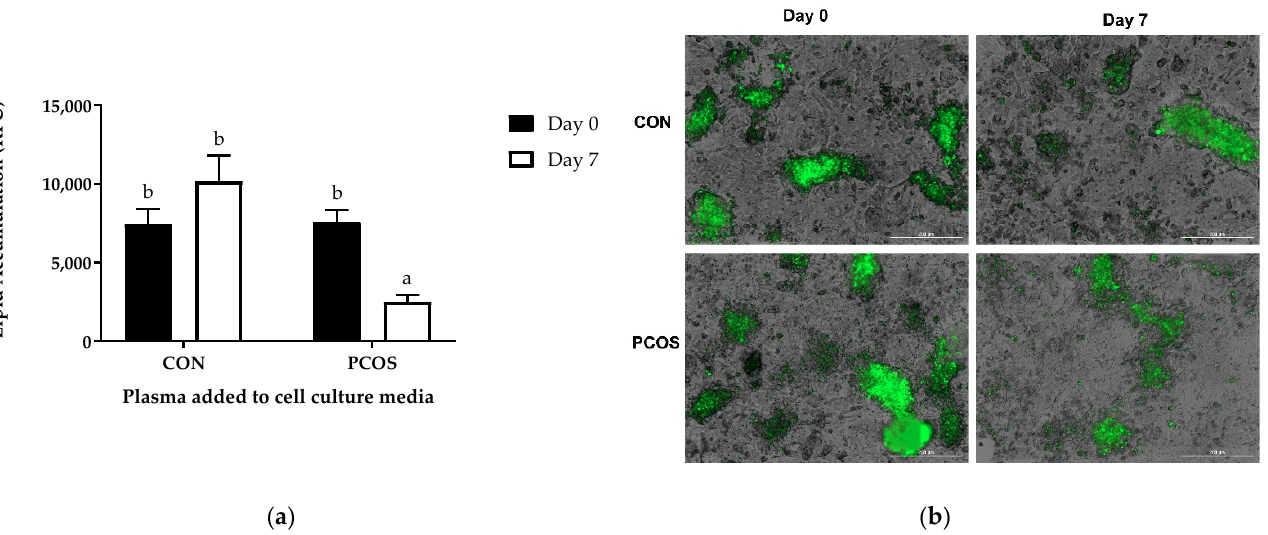
Figure 11. Lipid accumulation in HepG2 cells treated with plasma from CON and PCOS women before and after WPI supplementation: ( a ) bar graph representing the mean ± SD of fluorescent levels for each group (CON = 6, PCOS = 6); ( b ) representative photos of lipid droplets staining (shown in green) by AdipoRed. Different letters equate to statistically significant differences ( p < 0.05). CON = non-PCOS women; PCOS = women with polycystic ovarian syndrome; RFU = relative florescence units.